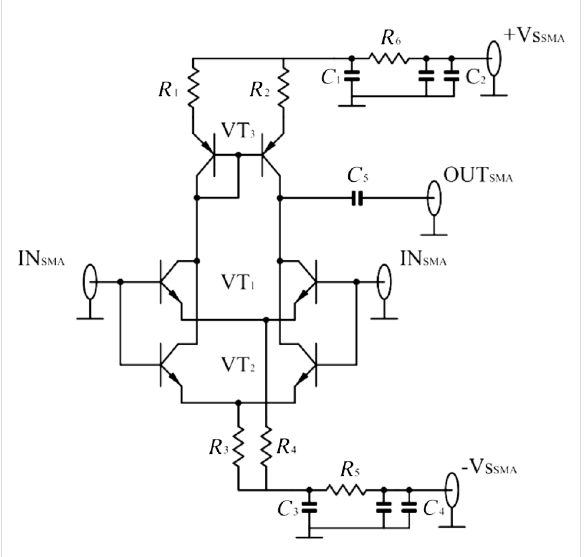
Figure 1: Schematic of the 0–120 kHz cryogenic LNA based on paired SSM2210 transistors. The important component values are: R 1 = R 2 = 100 Ω , R 3 = R 4 = 4.3 k Ω , C 5 = 470 nF. The capacitors are realized in 0402 package (C0G type) and the resistors are realized as uMELF. The other passive components are used for filtering of the bias